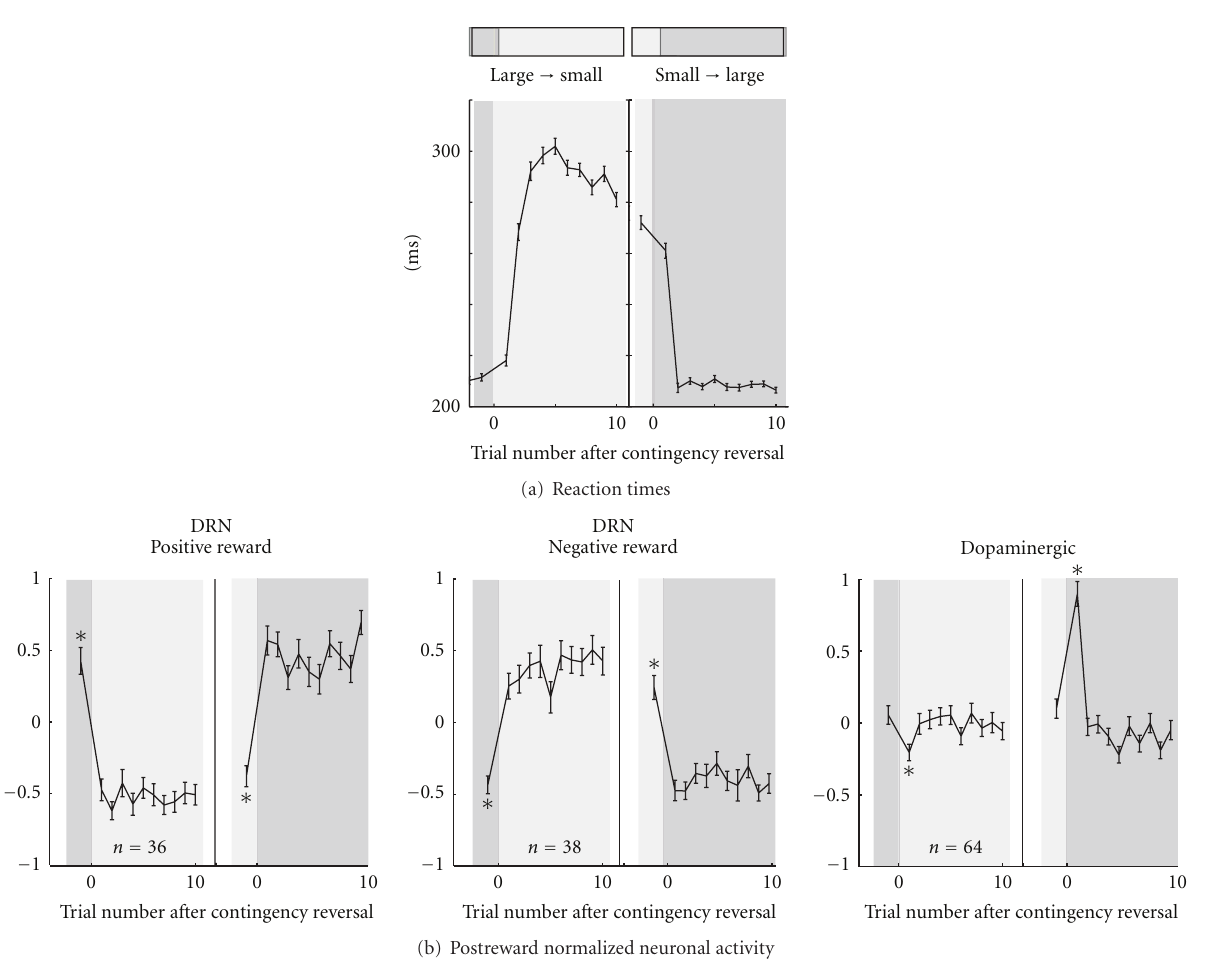
Figure 8: Changes in the reaction times and activity of DRN and putative dopaminergic neurons with reward contingency reversal. The reaction times (a) and normalized neuronal activity during the postreward period of DRN (400–800ms after reward onset) and putative dopaminergic neurons (0–400ms after reward onset) are plotted. In (b), the data are shown for DRN neurons with a large-reward preference (left), DRN neurons with a small-reward preference (middle), and putative dopaminergic neurons (right). Error bars, SEM. (Modified from